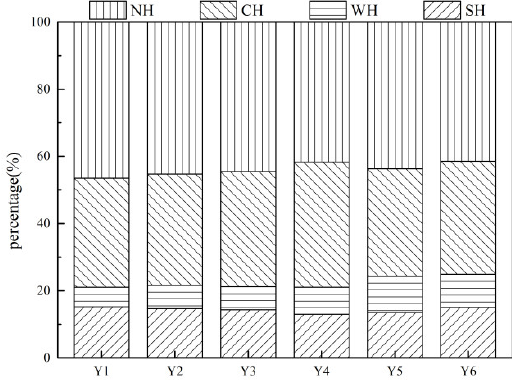
Figure 5. Hydrophilic and hydrophobic fractions of KS-DON.